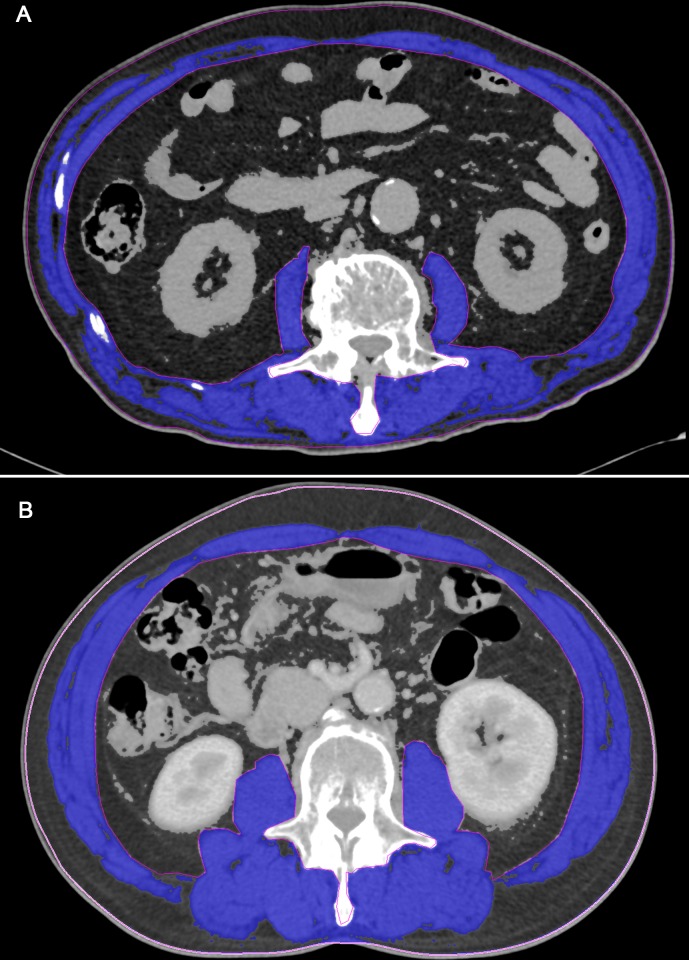
Single cross-sectional area of skeletal muscle at the third lumbar vertebrae and the level of C-reactive protein (CRP) in patients with small cell lung cancer.(a) In a 72-year-old male patients, the CT-measured L3 muscle (blue color) index was 43.4 cm2/m2 and the CRP was 11.58 mg/dL at the time of diagnosis. (b) In a 69-year-old male patients, the CT-measured L3 muscle (blue color) index was 75.0 cm2/m2 and the CRP was 0.09 mg/dL at the time of diagnosis.